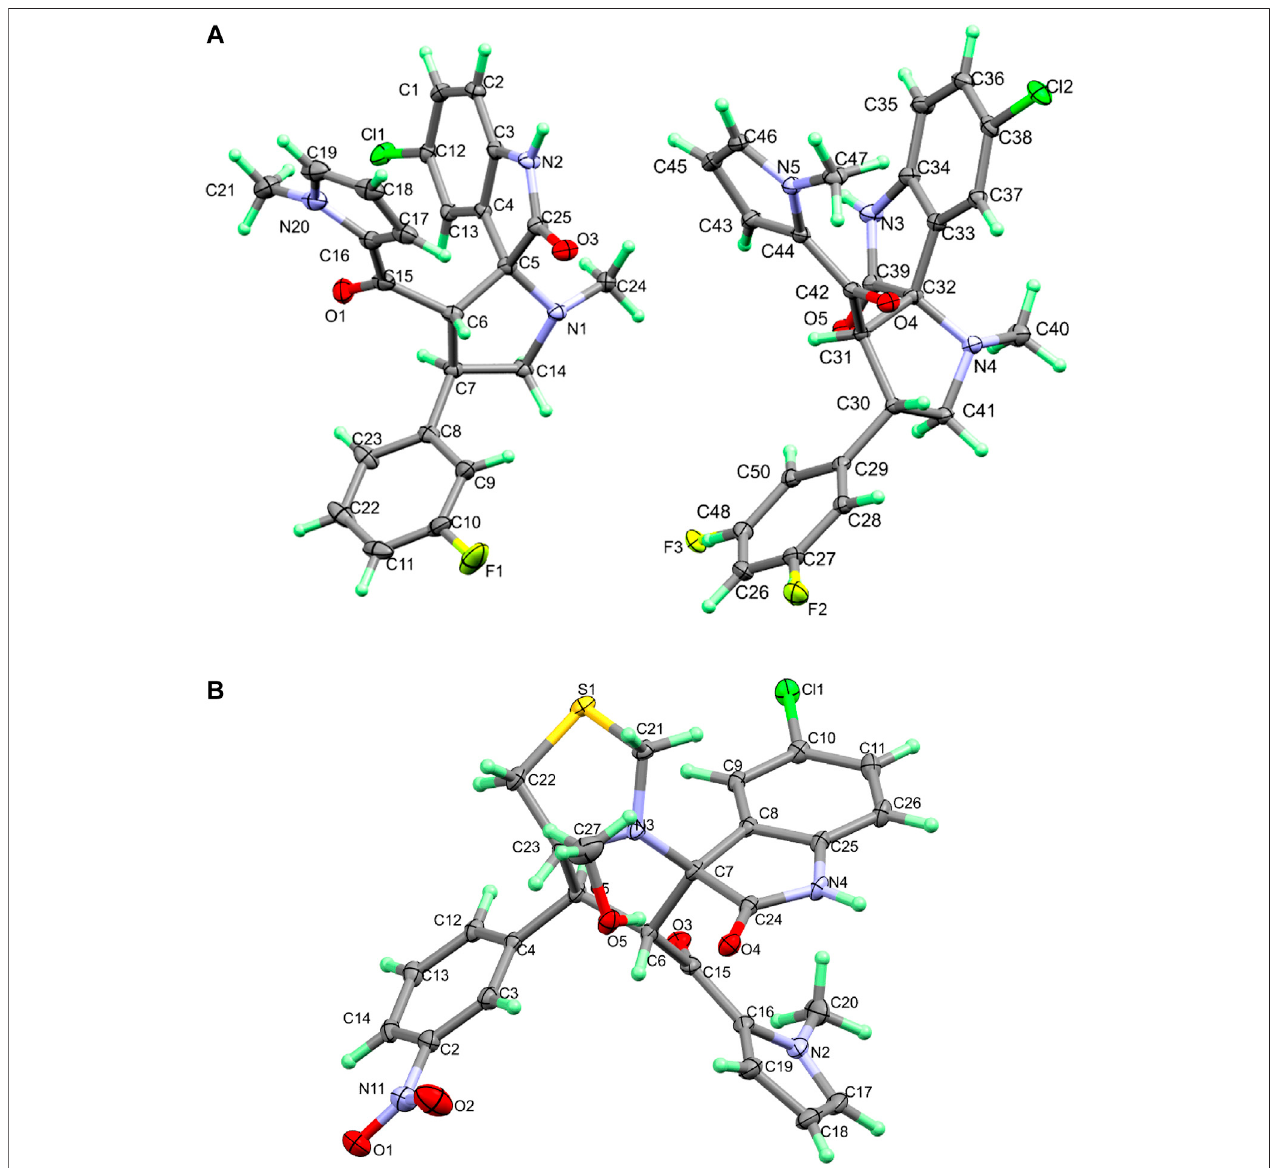
FIGURE 3 | Thermal ellipsoid plots at 30% probability level for 2a (A) and 2b (B) .